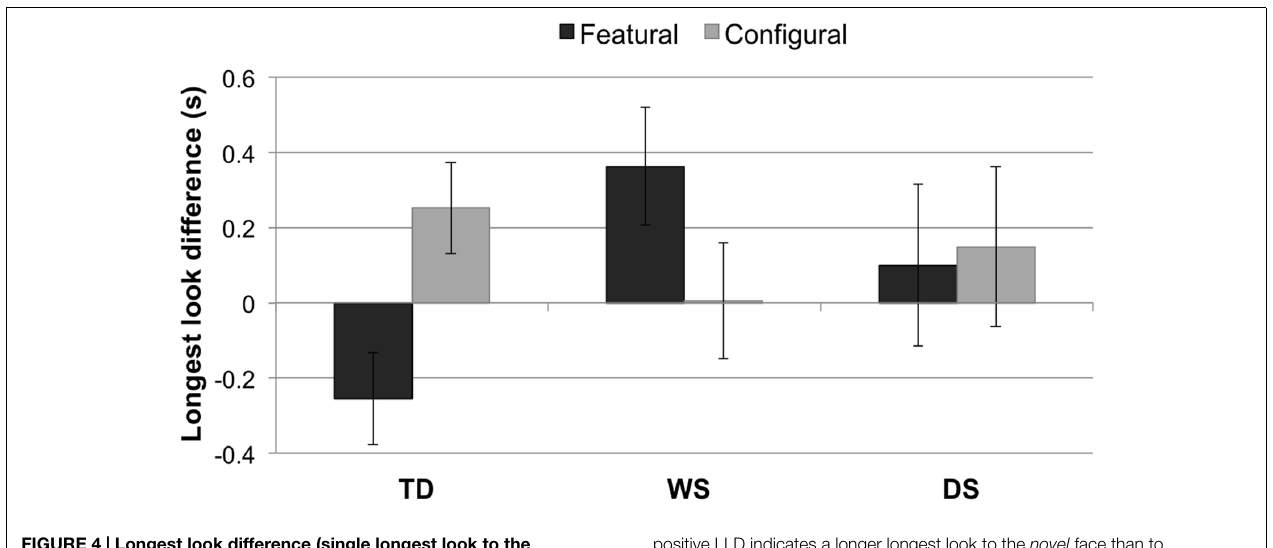
FIGURE 4 | Longest look difference (single longest look to the novel face minus the single longest look to the familiarized face, in seconds) for each condition (featural, configural) and group (TD controls, Williams syndrome, Down syndrome). A